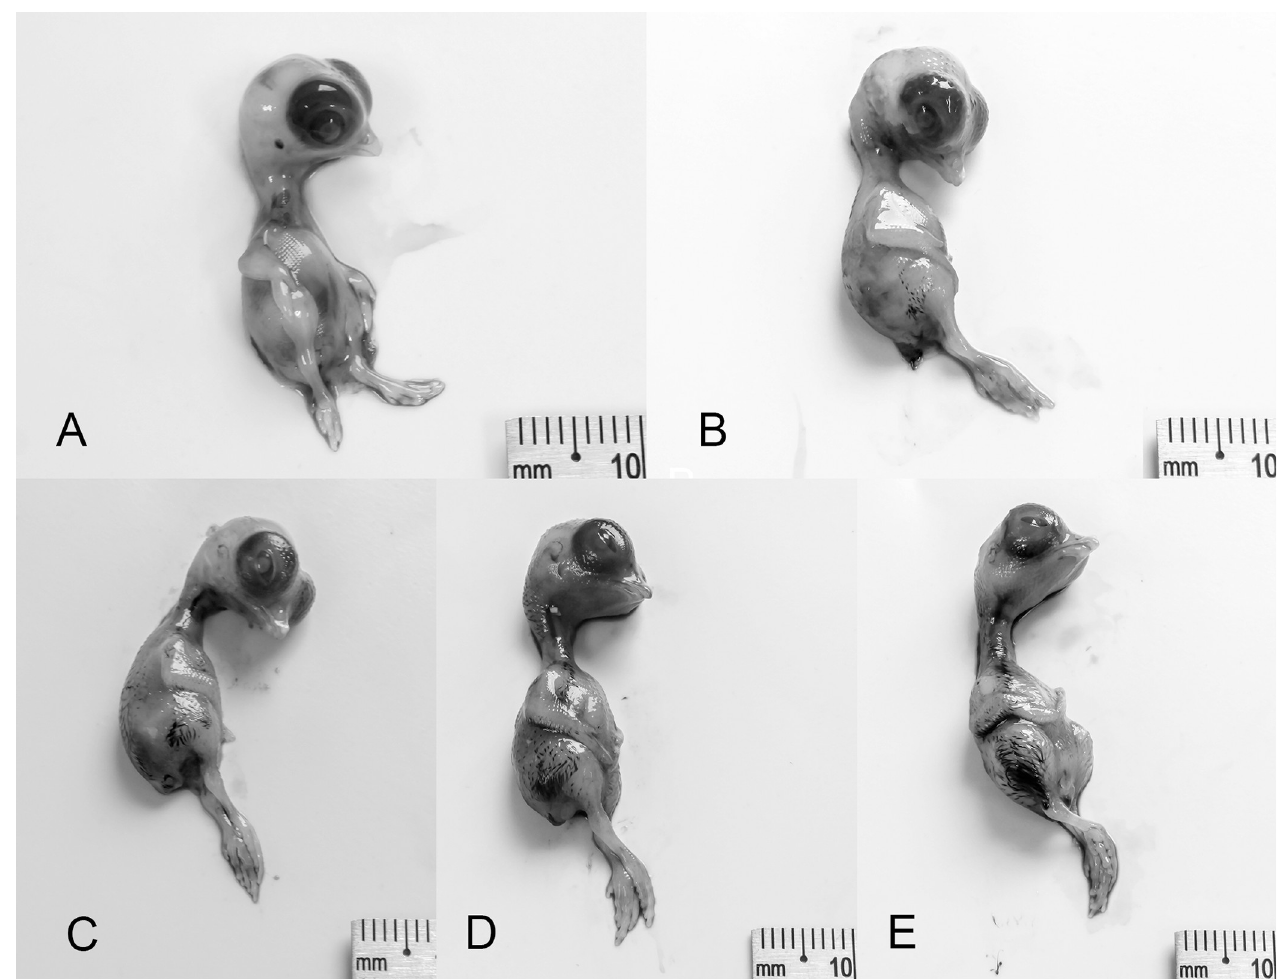
Fig 9. Stages 31–35 (10–14 d) of the California valley quail’s embryological stages of development. (A) Stage 31, primordia of claws. (B) Stage 32, 2 dorsal rows of pigmentation on either side of spine. (C) Stage 33, 4 dorsal rows of pigmentation of either side of spine. (D) Stage 34, brown pigmented feather tips appear along spine. (E) Stage 35, brown pigmentation identified on crown, anterior region of wing and along the thigh.